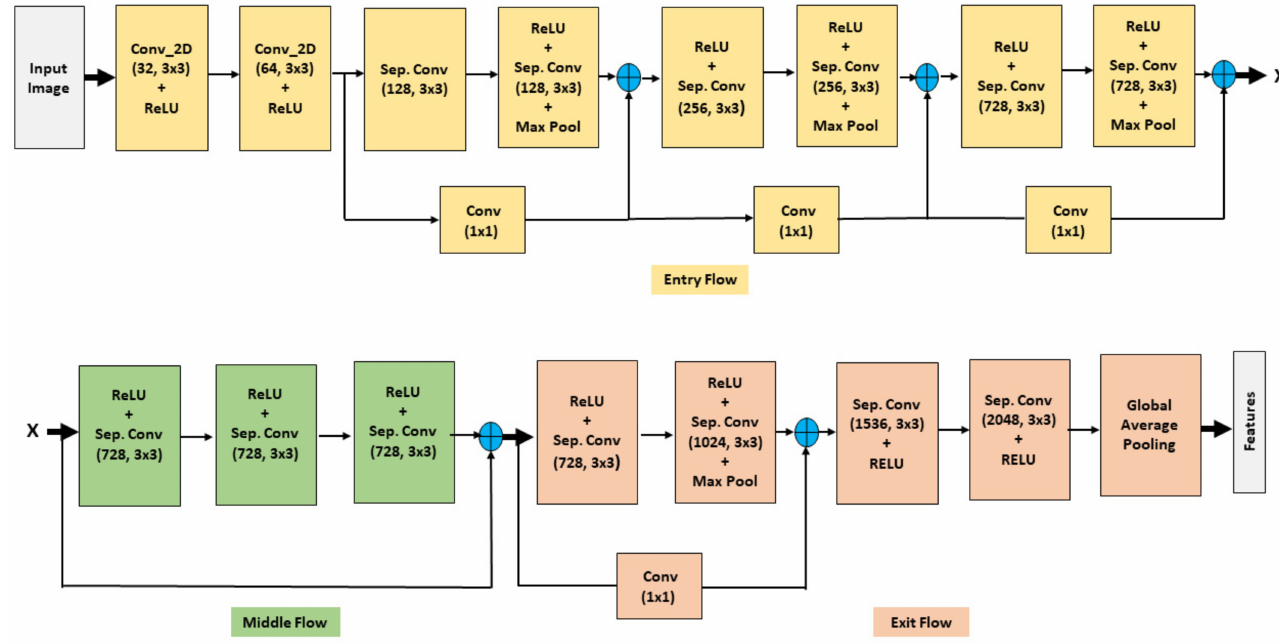
Figure 4. Framework of Xception